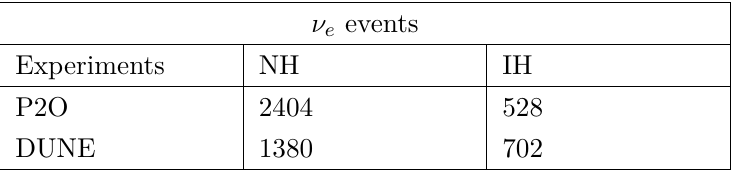
Table 3 . Total number of ν e events for P2O and DUNE. These events corresponds to 3 years running of P2O and 3.5 year running of DUNE.